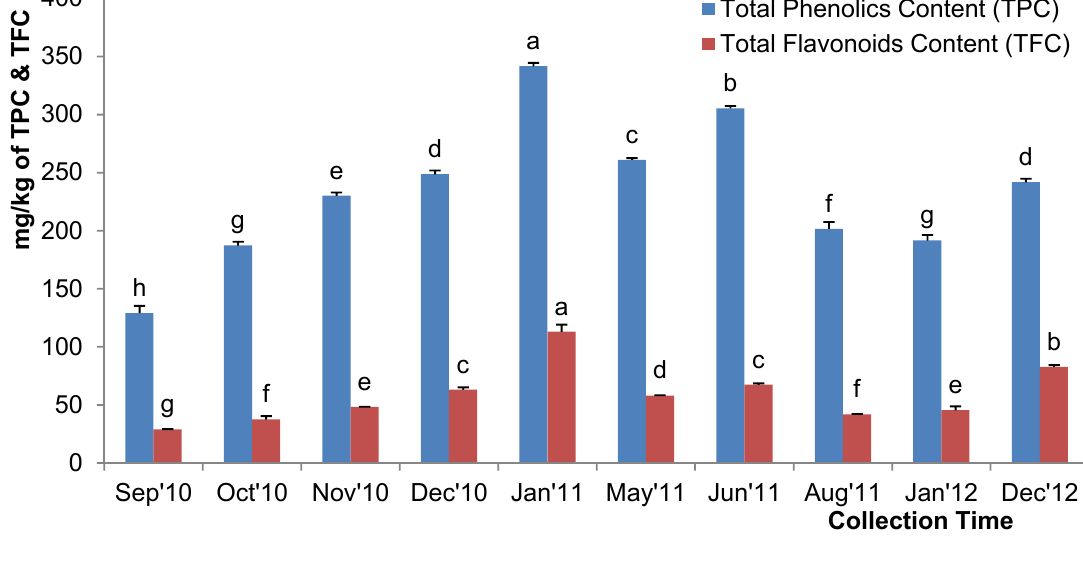
Figure 4. Total phenolic and flavonoid contents of the Malaysian acacia honeys. Values with different letters indicate significant differences ( p <